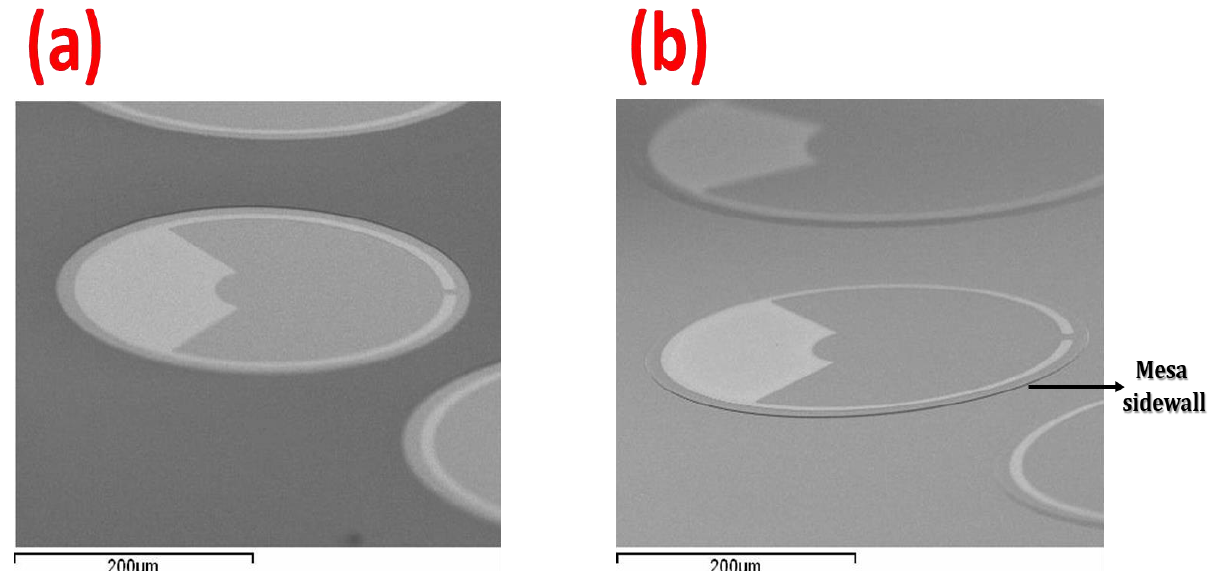
Figure 2. ( a ) Scanning electron microscope (SEM) image of the planar photodetectors. ( b ) SEM image of the conventional fully etched mesa-isolated T2SL photodetector where the mesa sidewall was marked.